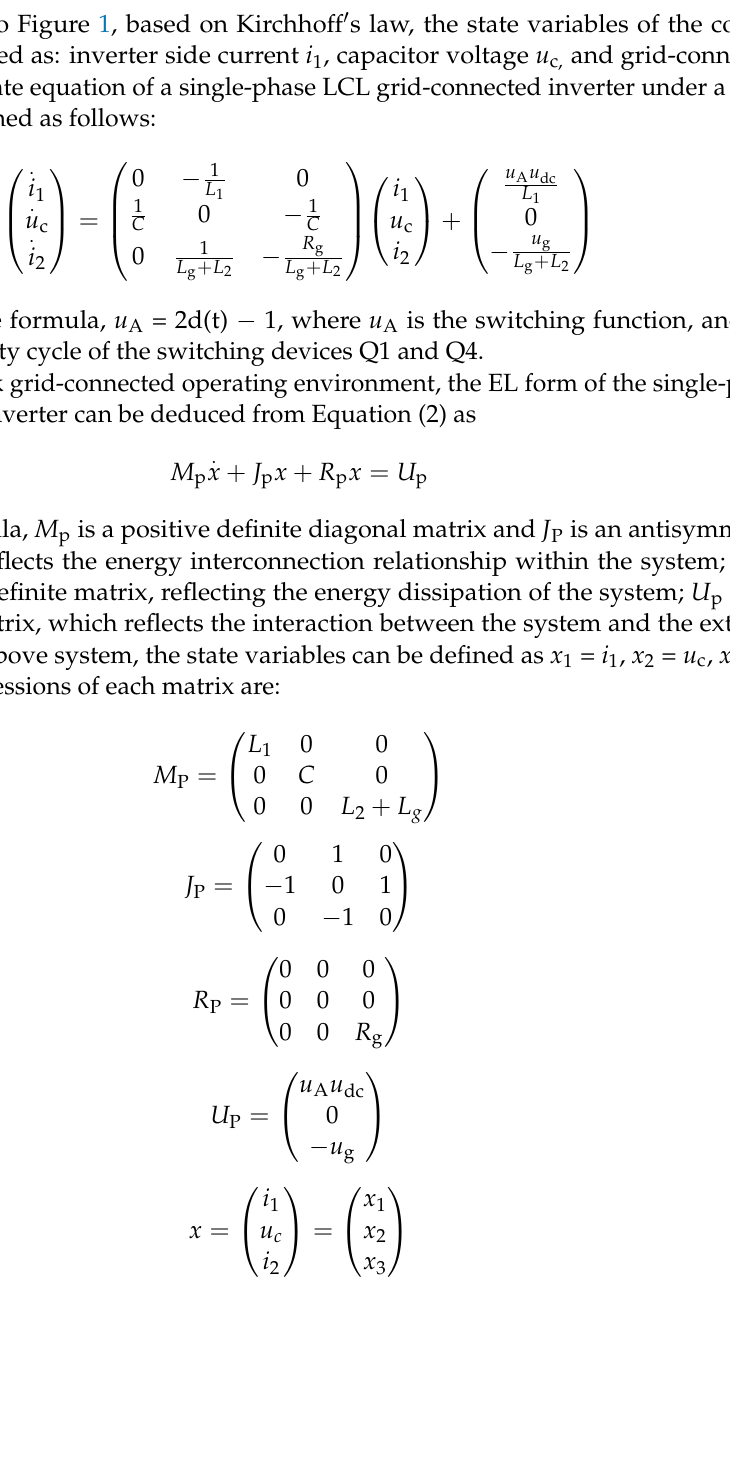
Figure 1. Equivalent model of single-phase LCL grid-connected inverter in the weak grid.